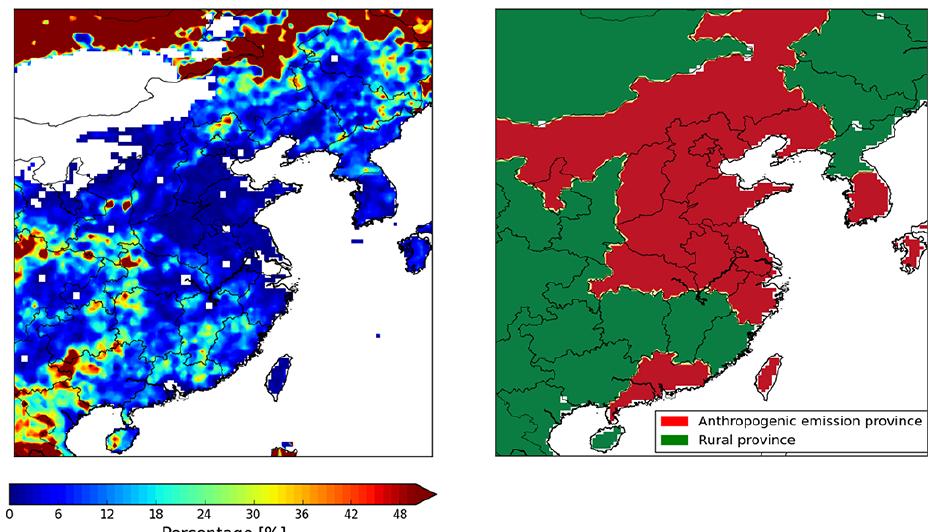
Figure 5. Ratio between biogenic and anthropogenic NO x emissions in summer (left) and the distribution of anthropogenic emission provinces and rural provinces (right). Biogenic emissions are from the MEGAN model used in CHIMERE. Anthropogenic emissions are from the MIX (2012) emission inventory.